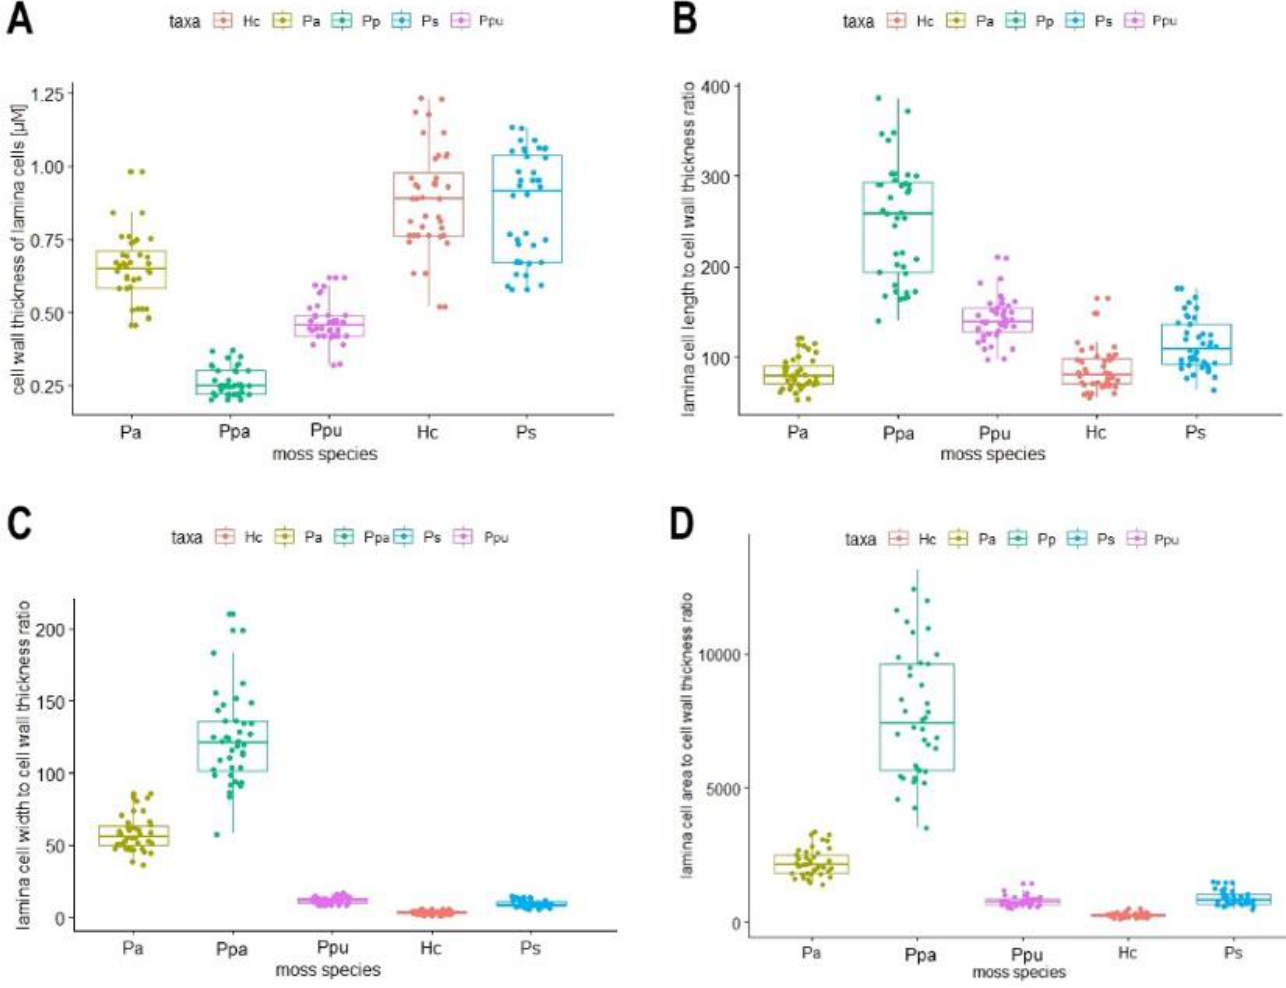
Figure 2. Box plots comparing the five investigated moss species. ( A ) cell wall thickness, ( B ) lamina cell length to cell wall thickness, ( C ) lamina cell width to cell wall thickness, and ( D ) lamina cell area to cell wall thickness. Pa: Plagiomnium affine , Ppa: Physcomitrium patens , Ppu: Pseudoscleropodium purum , Hc: Hypnum cupressiforme , and Ps: Pleurozium schreberi.